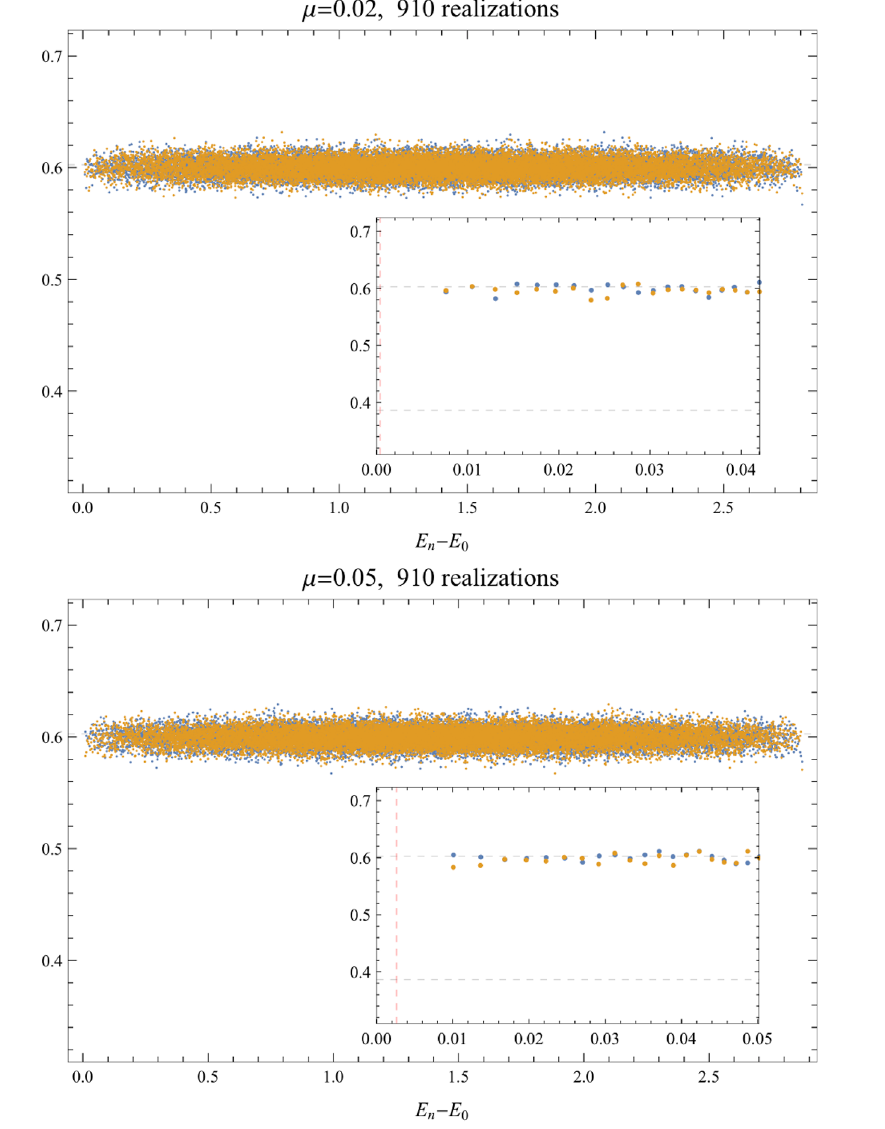
Figure 15 . Adjacent gap ratio r ( (cid:6) ) n of H ( (cid:6) ) for N = 30. Here the horizontal axis is def h i J ijk‘ E 0 with E 0 = min( E (+) ; E ( (cid:0) ) ) the energy of the true ground state. Inset: enlarged view for 0 0 i J ijk‘ (cid:12)rst 20 levels per each chirality sector, with dashed red line the peak temperature of the speci(cid:12)c heat in the large N limit (see (cid:12)gure 10) around which we would expect the chaotic/integrable transition if it